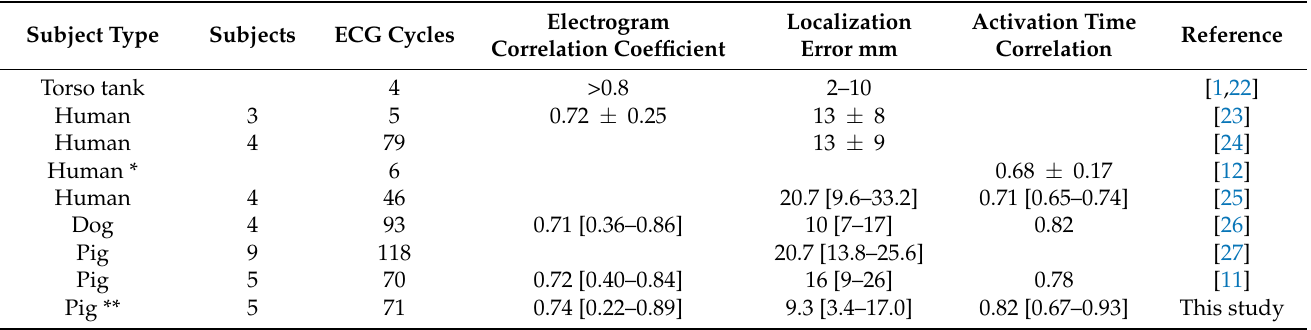
Table 2. Comparison with previous studies for the reconstruction of epicardial potential. This table is adapted from Table 2 with permission from Bear et al. [11]. The results are presented as the mean ± SD or the median [interquartile range]. * Only the results from paced data are show. ** The results shown here are from the CNN model in this